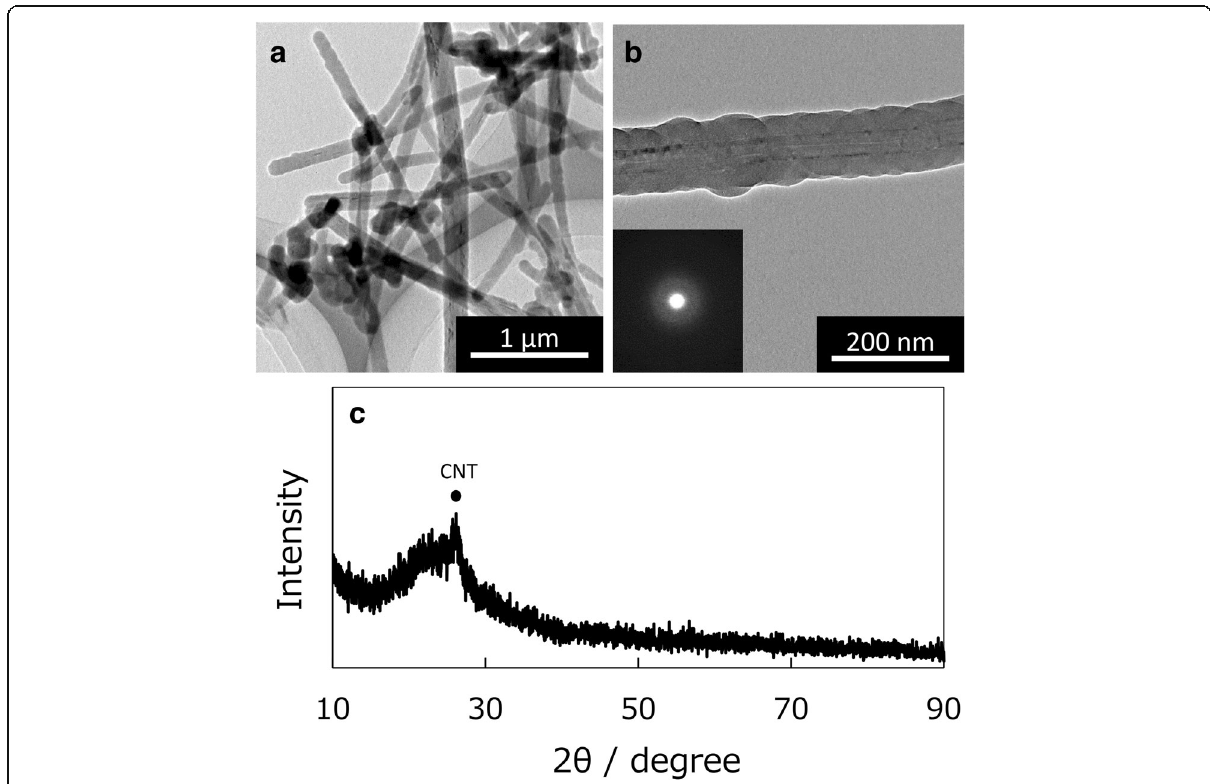
Fig. 1 TEM images ( a , b ) and XRD profile ( c ) of silica-coated